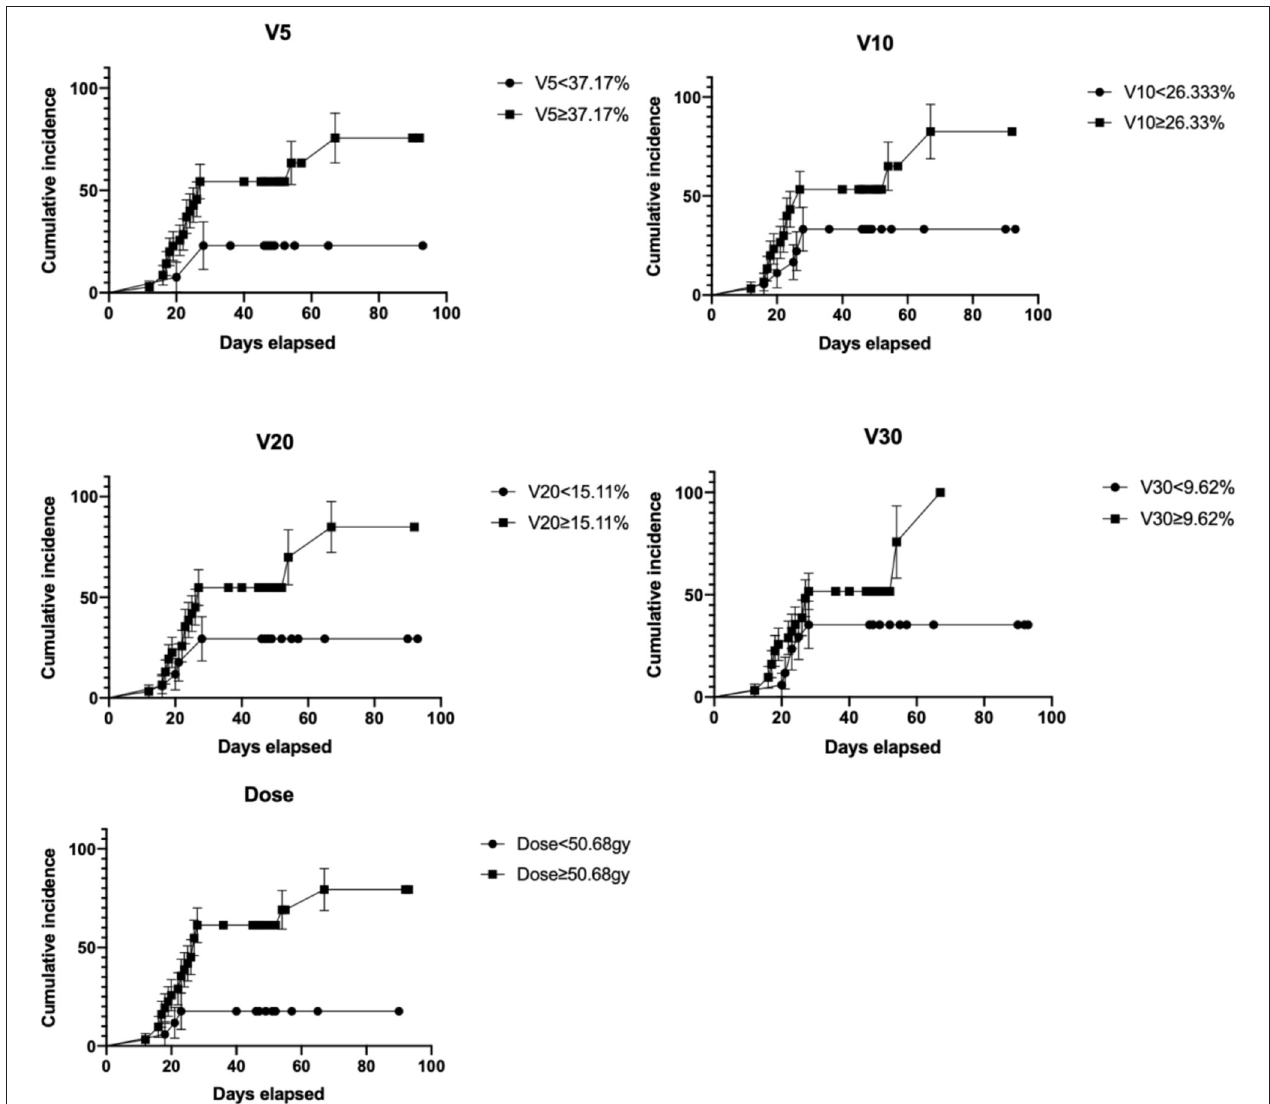
FIGURE 3 | Cumulative incidence rate curves of RP under different dosimetric parameters. The map shows the cumulative incidence rate of RP in the observation period (2–10w) under different physical parameters (V5, V10, V20, V30, and total target